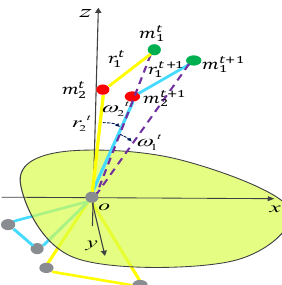
Figure 4. A simple particle system composed of two particles of the end point EP 1 and end point EP 2